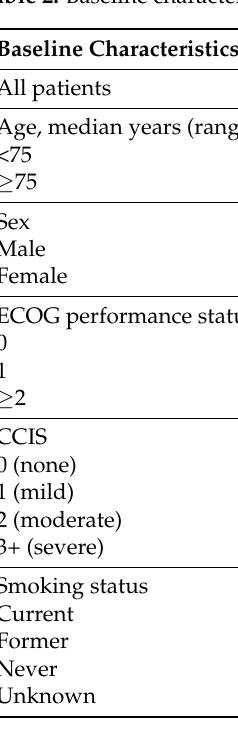
Figure 2. Overall survival (OS) of patients in Denmark before and after the approval of first-line immune checkpoint inhibitor (ICI). The survival of patients treated with chemotherapy (CTx) before the approval (pre) was compared to survival of patients treated with either CTx or ICI after the approval (post (CTx) and post (ICI)). DLCR, Danish Lung Cancer Registry. Table 2. Baseline characteristics, ICI